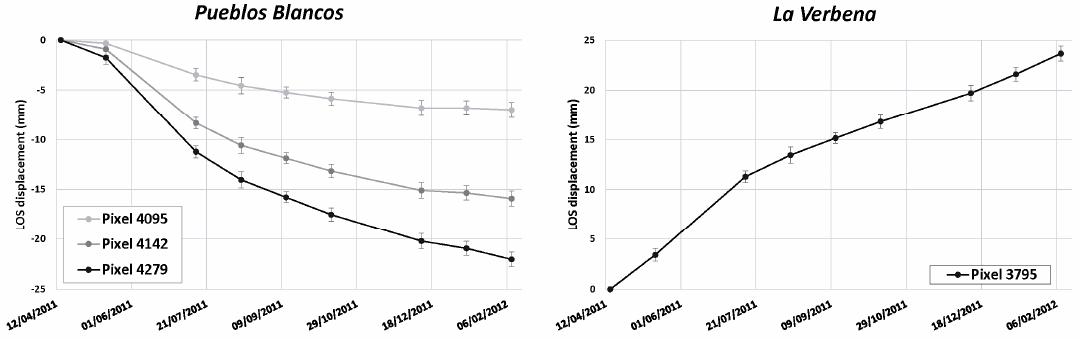
Figure 8. LOS deformation time series for a number of pixels for Pueblos Blancos and La Verbena. Their location is labeled in Figure 7.